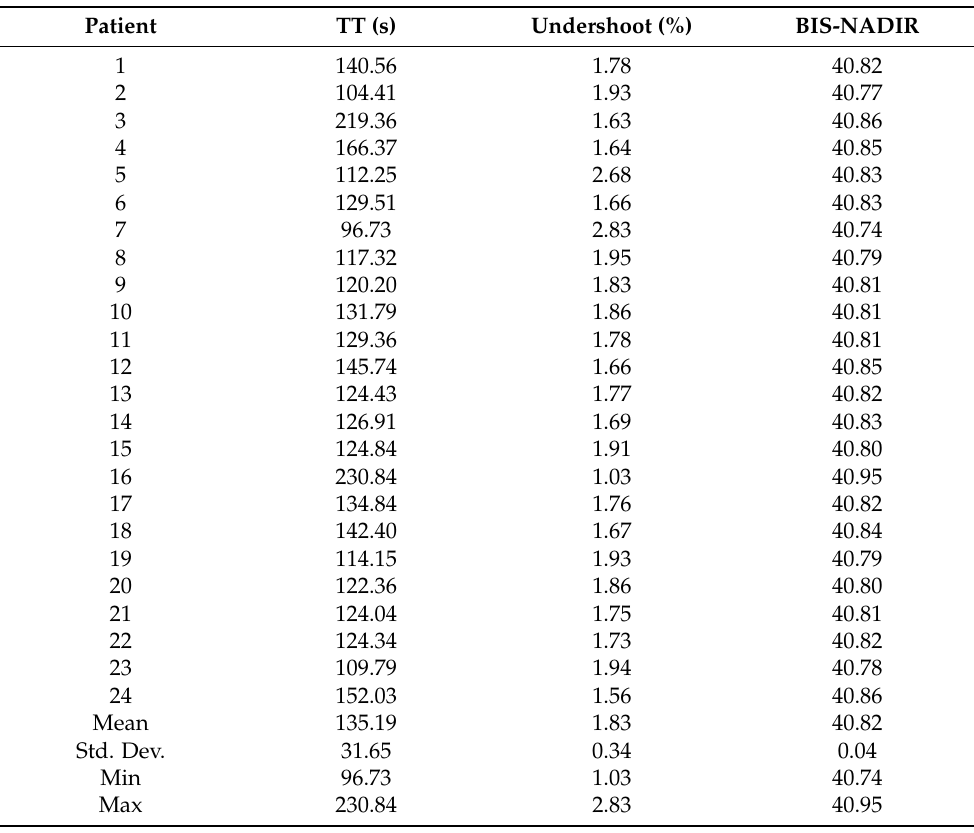
Figure 6. Detailed induction-phase BIS performances—simulation results for 24 patients. Table 2. Performance indexes for each patient’s